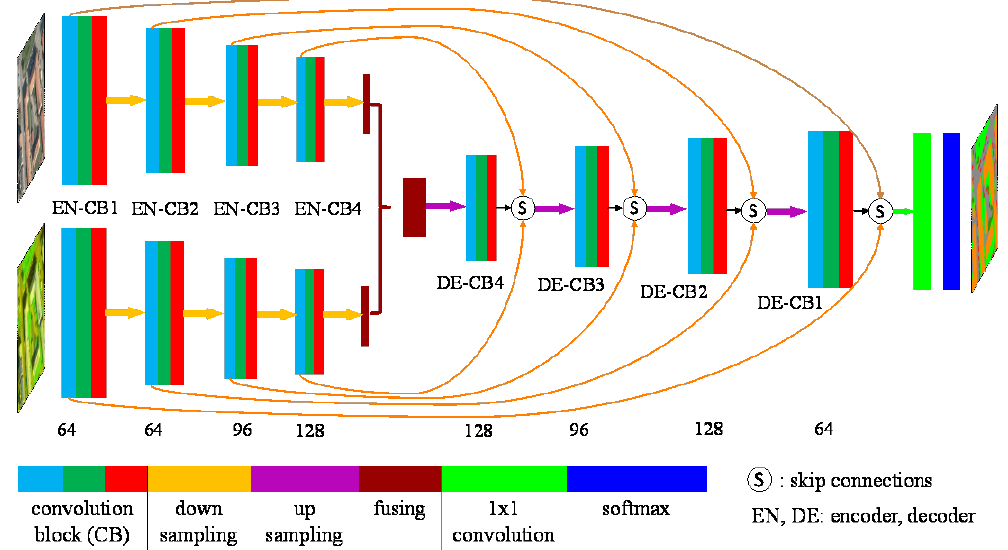
Figure 1: The network architecture ( FuseNet